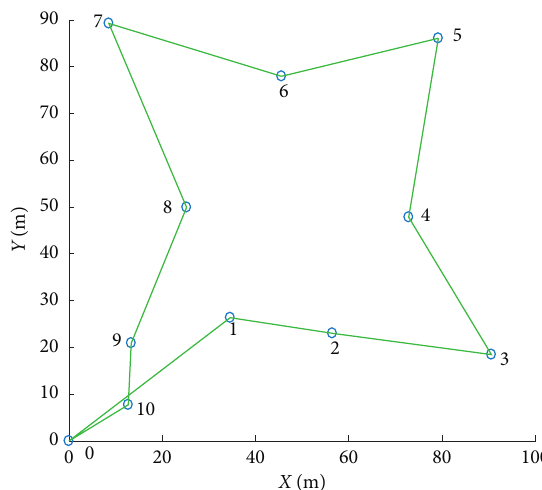
Figure 9: Planned access order for the first round prediction.